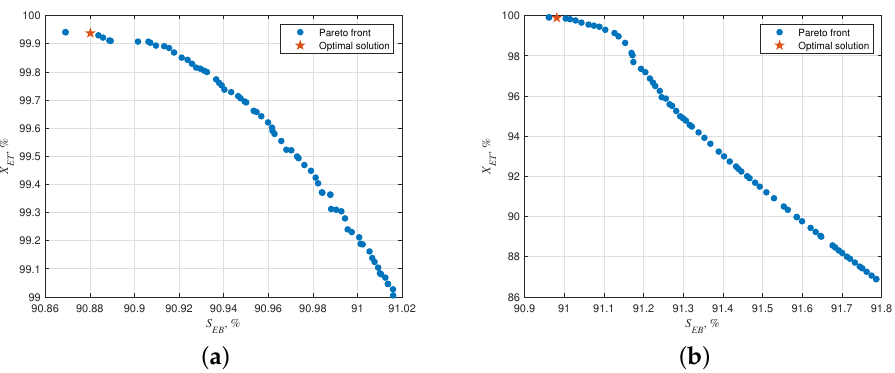
Figure 4. Pareto front of the selectivity and conversion. ( a ) Robust multi-objective optimization results, ( b ) Deterministic multi-objective optimization results.